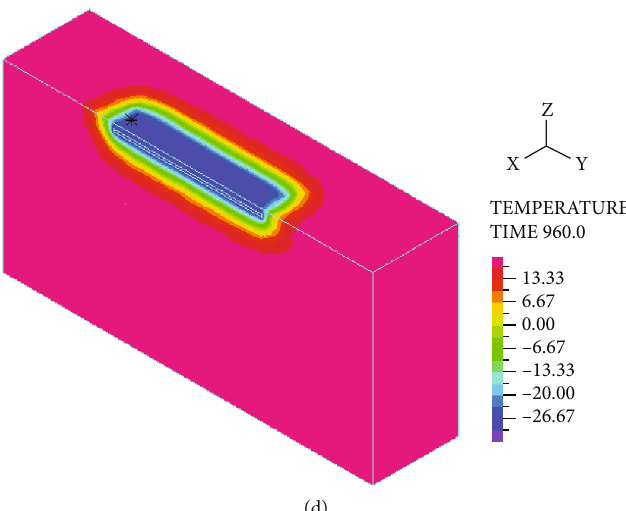
Figure 5: Schematic diagrams of the freezing devices.